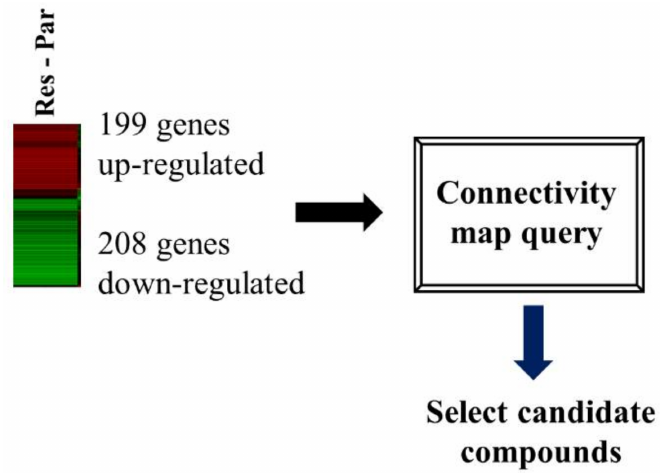
Figure 2. HSF1 was chosen as a potential target protein to overcome erlotinib resistance. A flow chart is shown of the CMap analysis procedure that was used to determine whether cephaeline could reverse erlotinib resistance. Gene expression profiling of RNA-seq was used to select DEGs for the erlotinib resistance phenotype. In HCC827-ErlR cells, 199 4-fold upregulated genes and 208 6.5-fold downregulated genes were selected for CMap